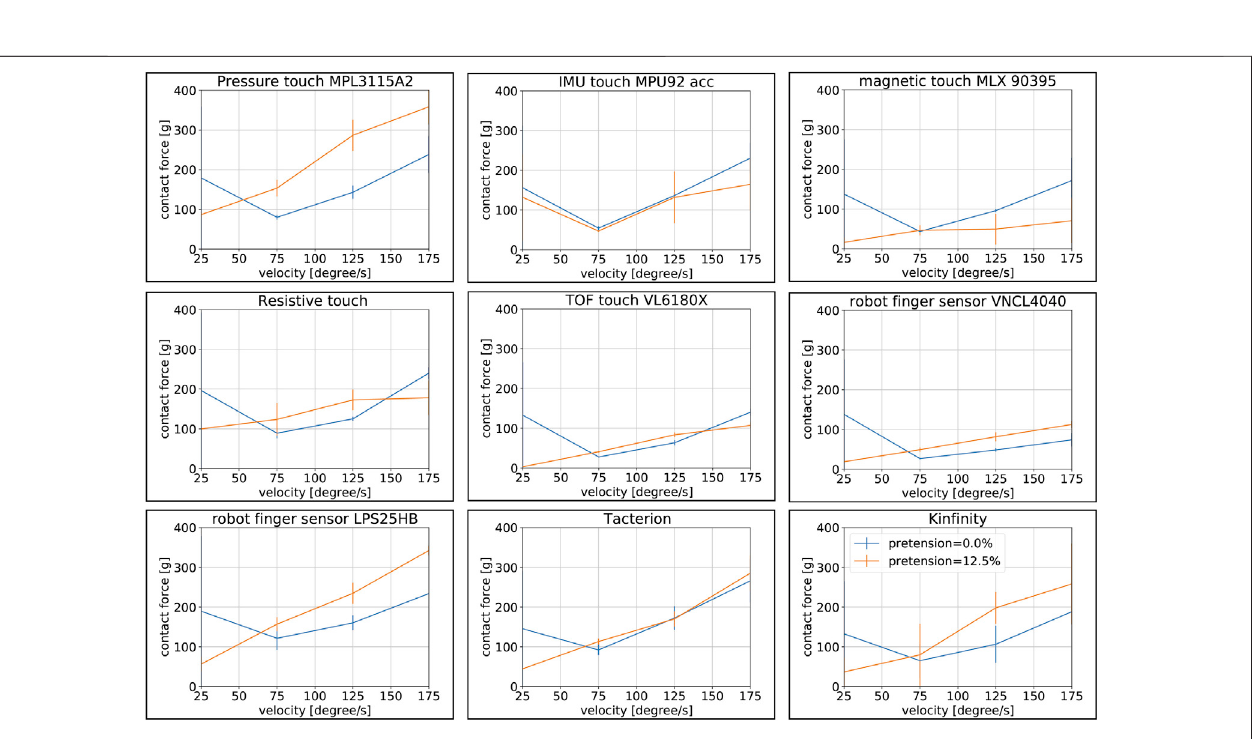
FIGURE 7 | Detected contact force for all nine sensors depending on joint stiffness and joint velocity. The blue line shows 0% pretension (corresponding to a stiffness of 0.23 Nm/rad and 0.12 Nm/rad in the base and distal joint, respectively) and the orange line 12.5% pretension (corresponding to a stiffness of 0.34 Nm/rad and 0.16 Nm/rad in the base and distal joint,